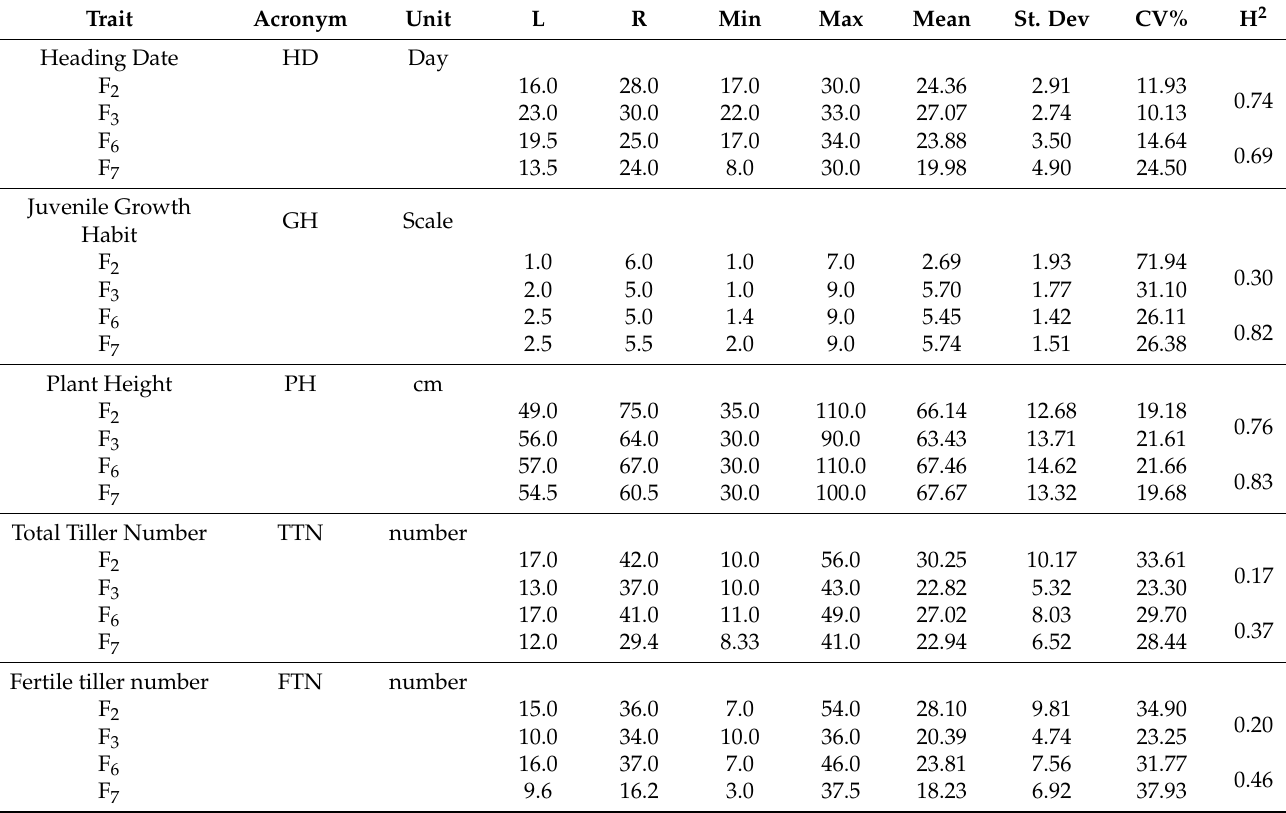
Table 1. Minimum, maximum, mean, standard deviations (St. Dev), coefficient of variation (CV), and heritability (H 2 ) for five traits in the F 2 , F 3 , F 6 , and F 7 populations. Phenotipic values of both parents (Lankaodali, L and Rebelde, R) are also